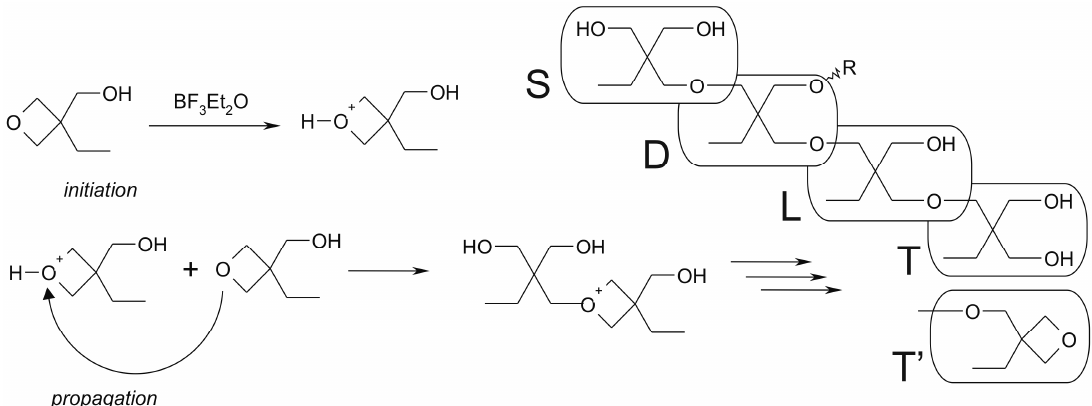
Figure 1. Cationic polymerization of 3-ethyl-3-hydroxymethyloxetane.